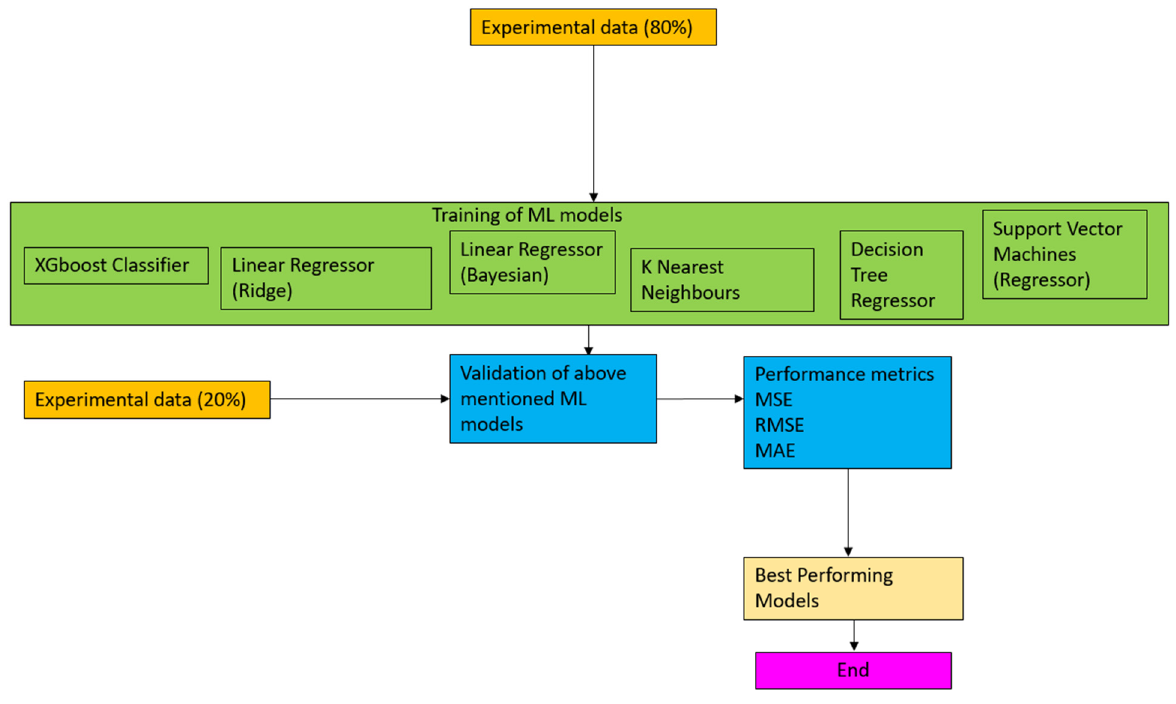
Figure 4. Flowchart for prediction of linear-law and power-law coefficients using the proposed models.